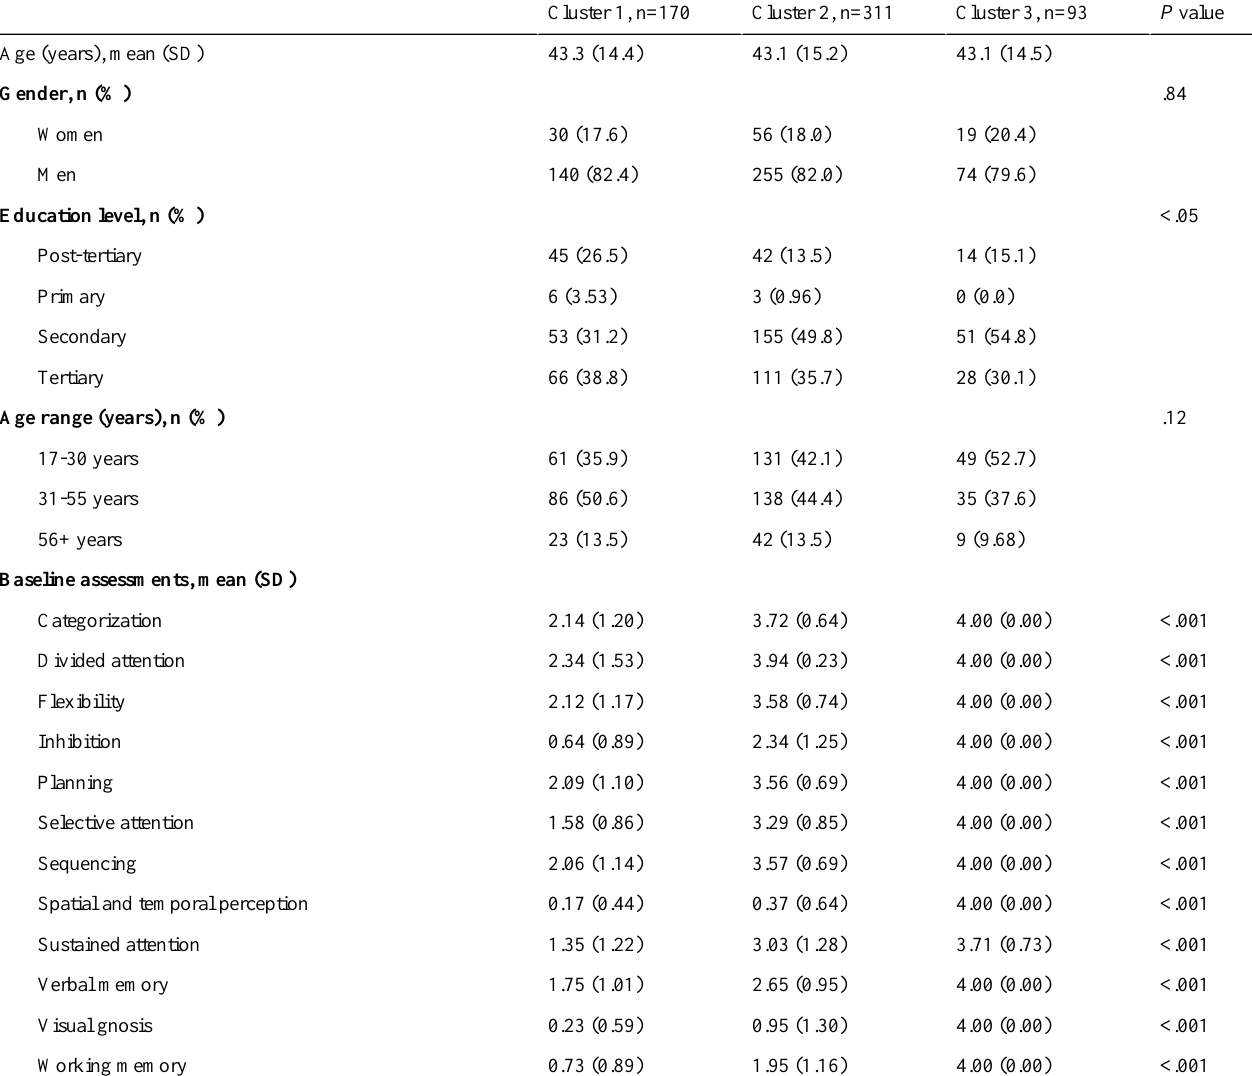
Table 2. Univariant analysis of the obtained clusters